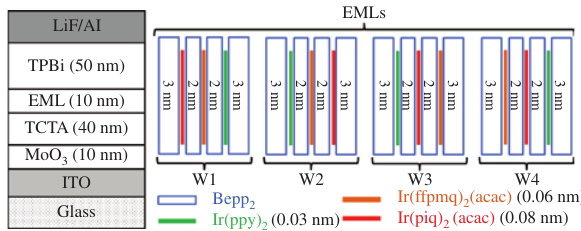
Figure 3: Device structure diagram of the proposed hybrid white devices W1, W2, W3, and